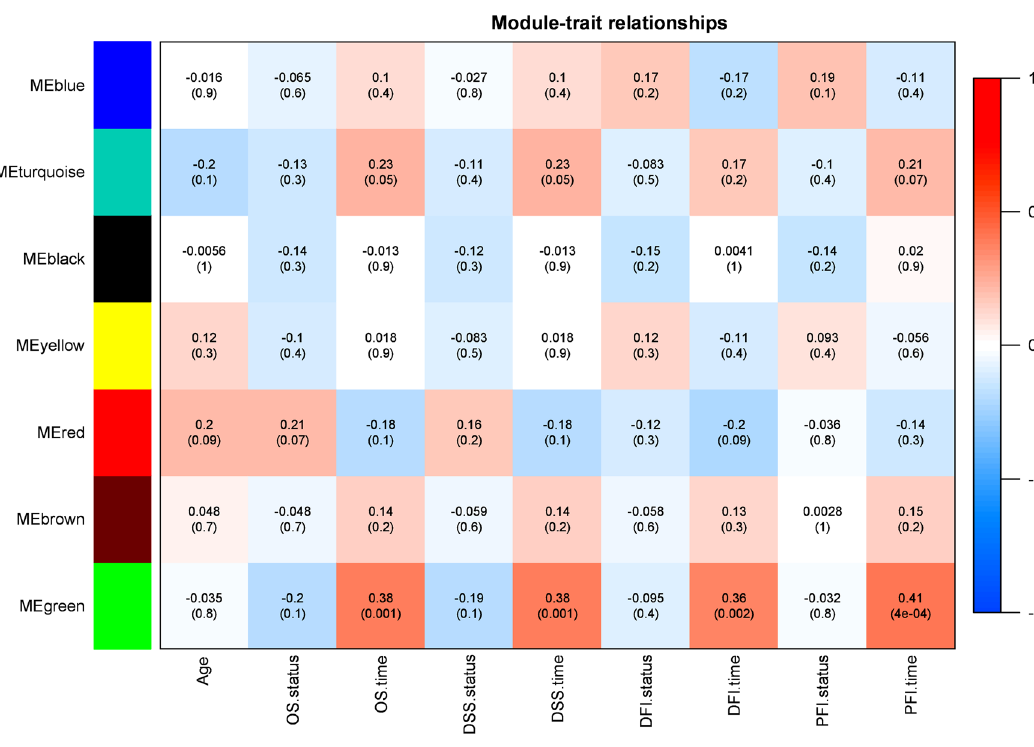
Figure 4. The module–trait relationships were demonstrated by correlation values and P values (In parenthesis) with a range of colors; the degree of correlation between modules and clinical features is shown. Rows are module eigengene (ME) regards to each module, and the columns indicate